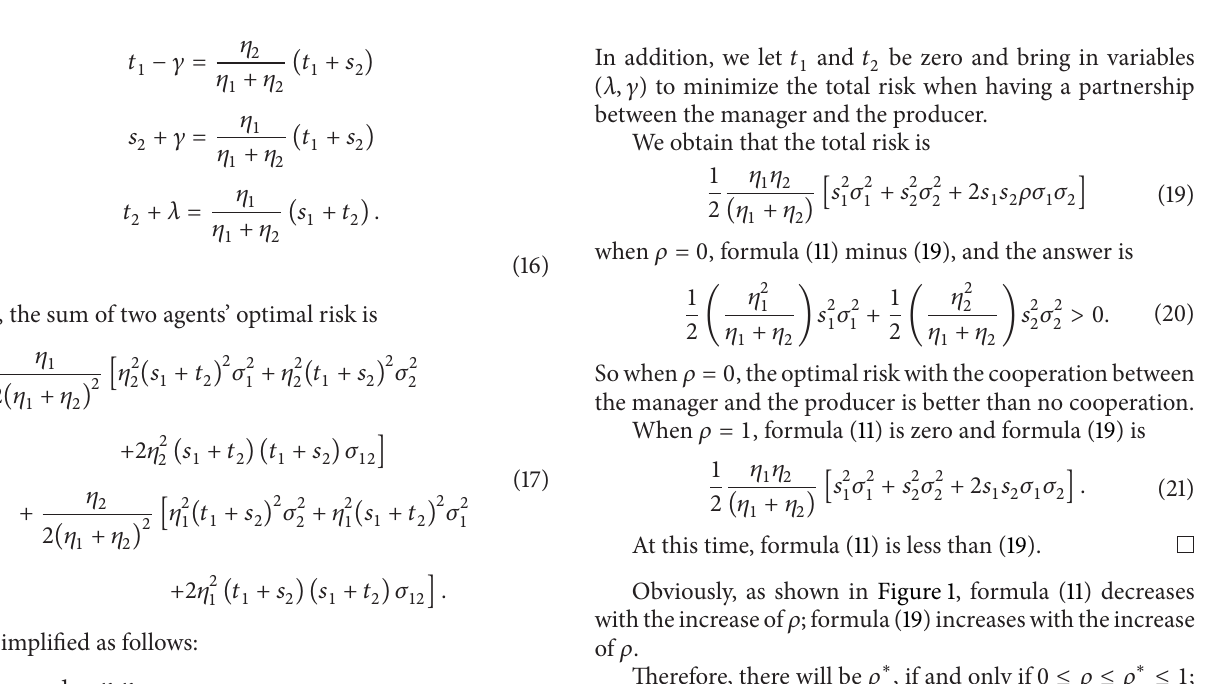
Figure 1: The relationship between the total risk and the correlation coefficient 𝜌 . Notes . Curve 1 indicates the sum of optimal risks when having the cooperation between the manager and the producer; Curve 2 indicates the sum when having no